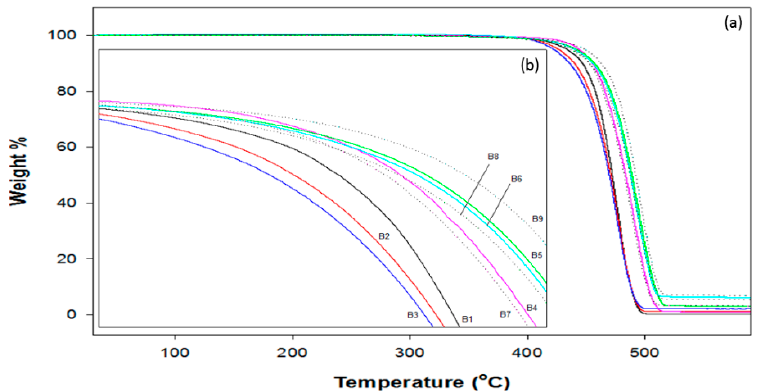
Figure 5. ( a ) Thermal gravimetric analysis (TGA) curves of pristine LDPE and its composite films. ( b ) Expanded degradation curves.